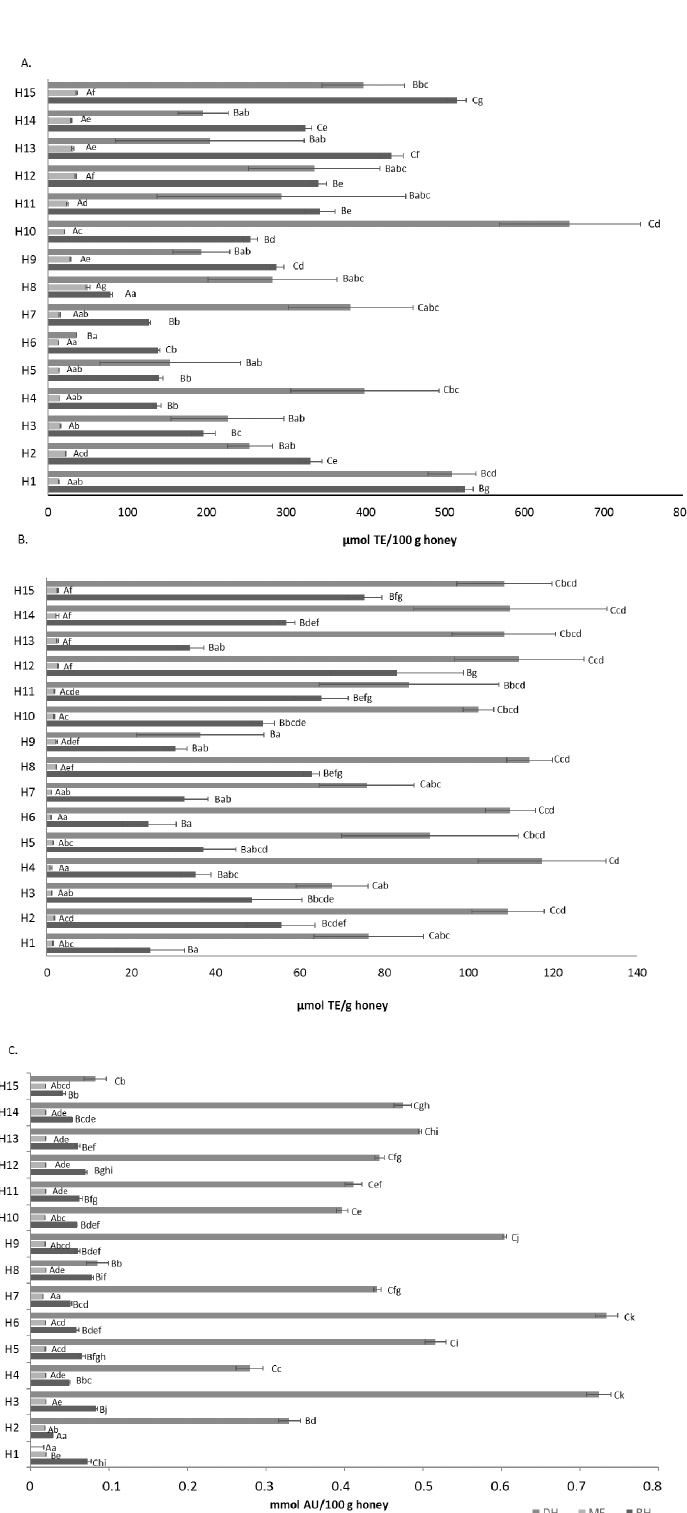
Figure 2. Antioxidant activity of raw honeys (RH), methanolic extracts (ME) and digestive extract (DH) against different radicals (ABTS •+ ( A ), ROO • ( B ) and • OH ( C )). Error bars represent the standard deviation for each data point. Different capitals letters (A–C) indicate significant differences ( p < 0.05) between extractions comparing the same sample. Different lowercase letters (a–g) indicate significant differences ( p < 0.05) between samples with the same extraction.